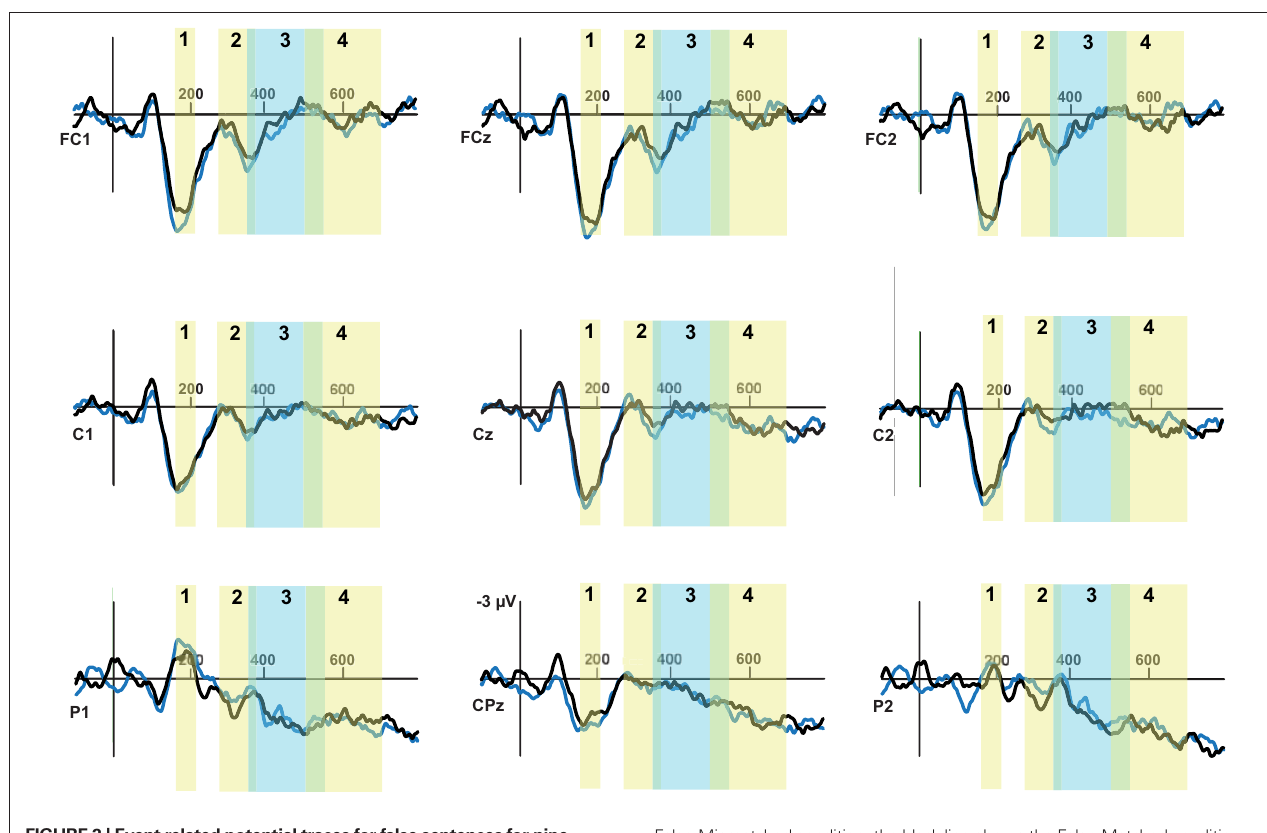
False-Mismatched condition, the black line shows the False-Matched condition. The limits of the early (270–370) and late (500–700) time windows for analysis are indicated.